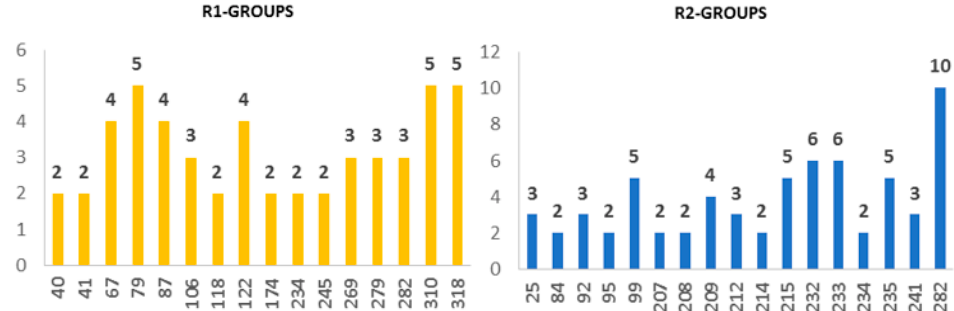
Figure 6. Histograms of frequency of occurrence of individual R-groups in the 90 best selected analogs mapping to four features of the PH4 pharmacophore hypothesis Hypo1 (for the structures of the fragments see Table 5); R 1 = -3-Br-2-(thiazol-2-yl)propyl (79); -3-F-1H-pyrazol-1-yl (310); -5-Et-1H- pyrazol-1-yl (318) and R 2 = -(3-F-cyclopenta-2,4-dien-1-yl)(MeAmino)Me (232); -(2-F-cyclopenta-2, 4- dien-1-yl)(MeAmino)Me (233) and -Bz-2-Me (282).